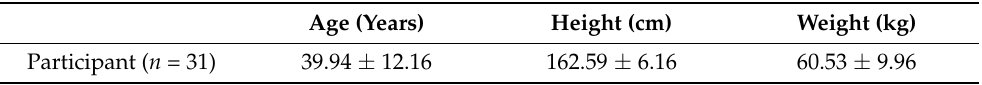
Table 1. Population information of the participants (mean ±